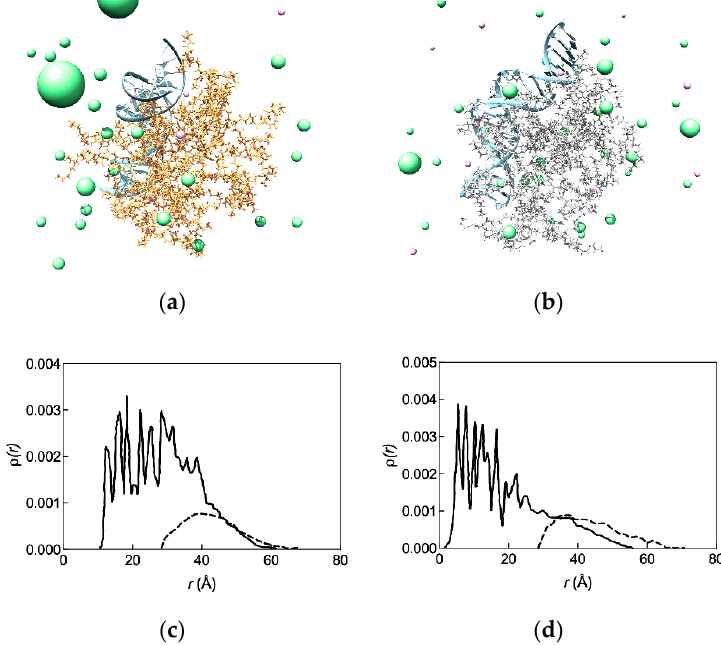
Figure 3. Equilibrated molecular dynamics conformations of G 5 TEA-core ( a ) and NH 3 -core ( b ) PAMAM dendrimers in complex with Hsp27 siRNA in physiological solution (pH = 7.4, ionic strength = 0.15 M NaCl). Each dendrimer molecule is represented as colored sticks, some ions and counterions are visualized as light pink (Na + ) and light green (Cl − ) spheres, the siRNAs are portrayed as light blue ribbons, and water molecules are not shown for clarity. Radial density distribution ρ ( r ) of the dendrimer terminal nitrogen atoms in G 5 TEA-core ( c ) and NH3-core ( d ) PAMAMs in complex with Hsp27 siRNA (continuous lines). The corresponding distributions of the siRNA phosphorous atoms in each siRNA/dendrimer complex are shown as dashed lines. Adapted from [35,36] with permission of John Wiley and Sons and Bentham Science Publishers.